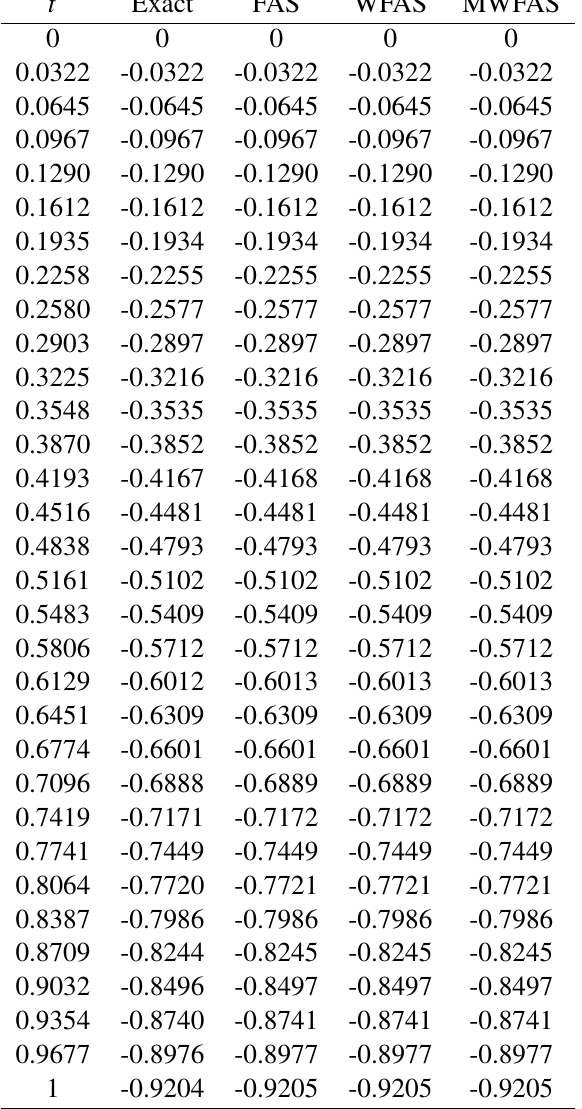
Table 9 Numerical results of test problem 5.5, for N = 32